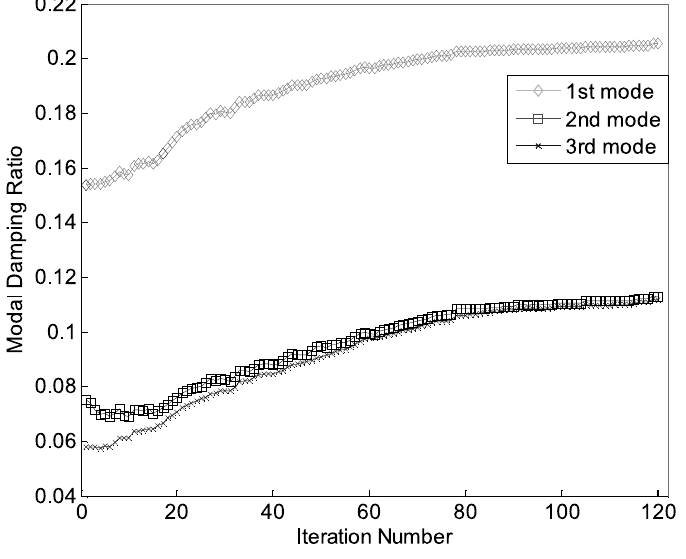
Fig. 11. Iteration histories for different modes vf = 0.6.